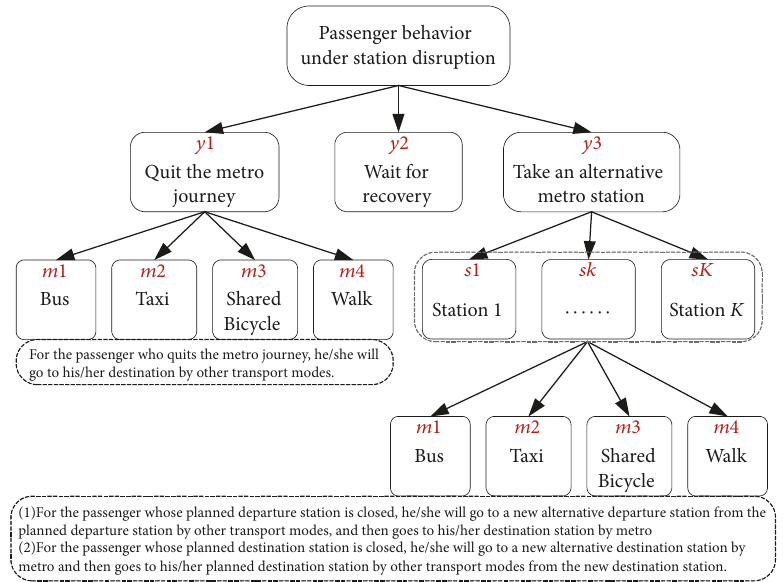
Figure 4: The nested-logit model for passenger behavioral choices under station